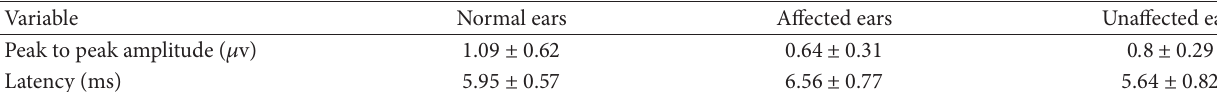
Table 2: The mean of the right and left latencies and amplitudes of auditory brainstem response to 500 HZ tone burst (ABR 500 patient and the normal groups.